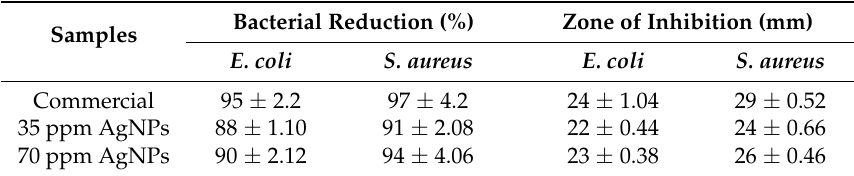
Figure 9. Antibacterial activity of ( 1 ) the commercial and AgNPs-treated fabrics ( 2 ) 35 ppm, ( 3 ) 70 ppm on ( a ) E. coli and ( b ) S. aureus . Table 2. Antibacterial activity of silk fabric coated with green-based